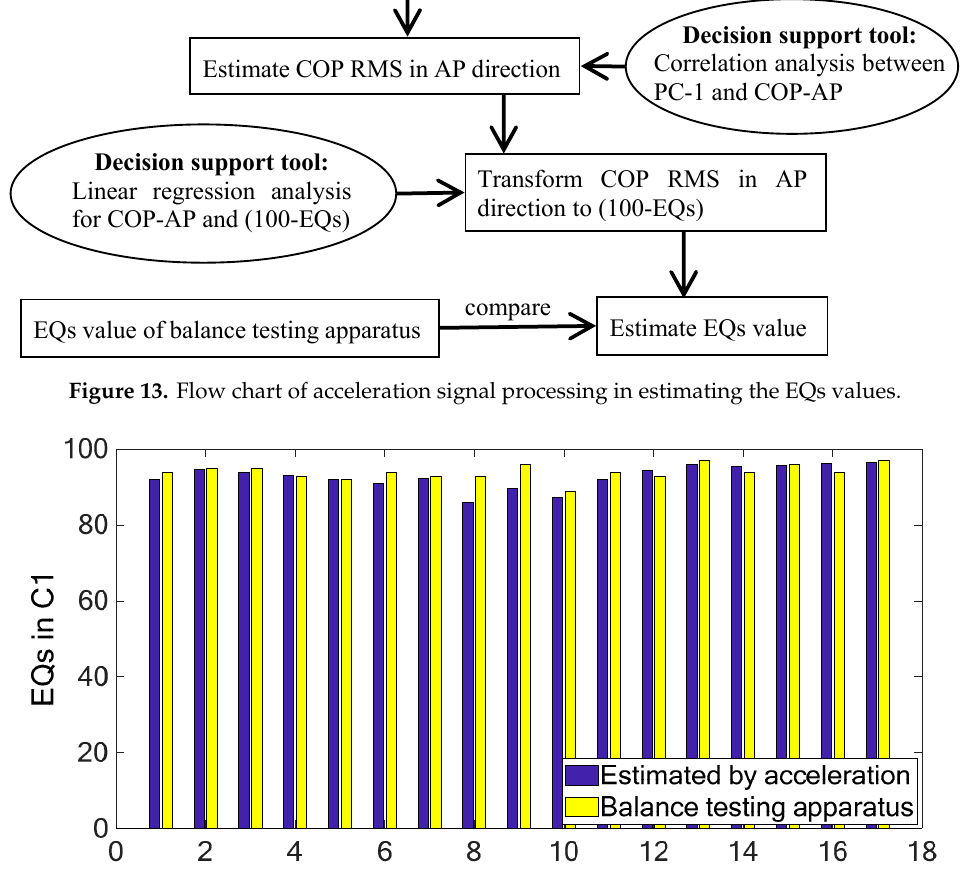
Figure 14. Estimated EQs values compared with EQs values of commercial computer-aid balance testing apparatus in C1.